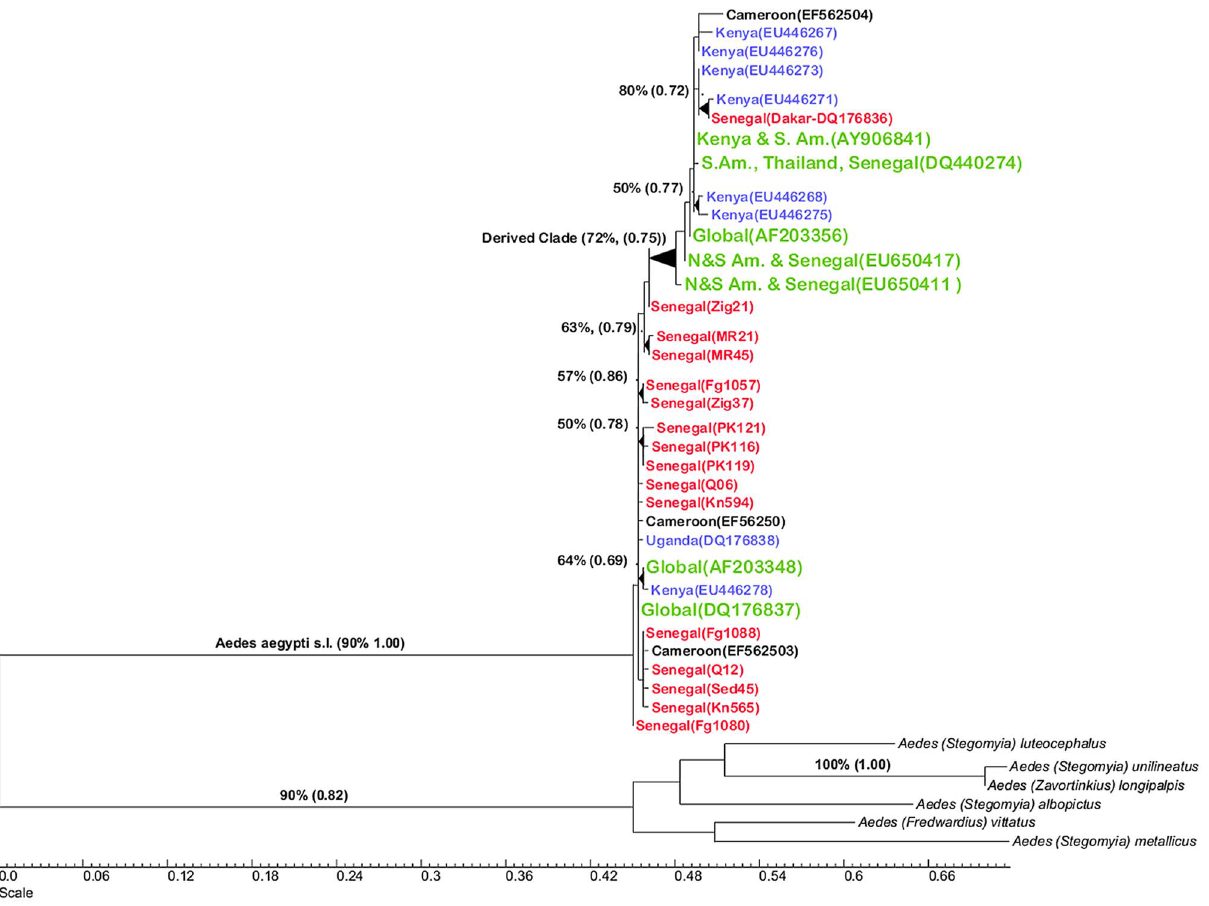
Figure 1. Maximum likelihood tree of the 34 mtDNA ND4 Ae.aegypti haplotypes found to date in Africa and outgroups. These were comprised of the 15 new unique Senegal haplotypes from the present study and one Senegal haplotype collected in Dakar in a previous study (labeled in red). Seven novel haplotypes from Kenya and one from Uganda (in blue), three from Cameroon (in black) and seven haplotypes (in large green font) that appeared in collections from Africa and other global locations in various other studies (Table S1). Branches with bootstrap support values . 50% are labeled with % support. These support values are followed by clade credibility values in parentheses from MrBayes analysis.